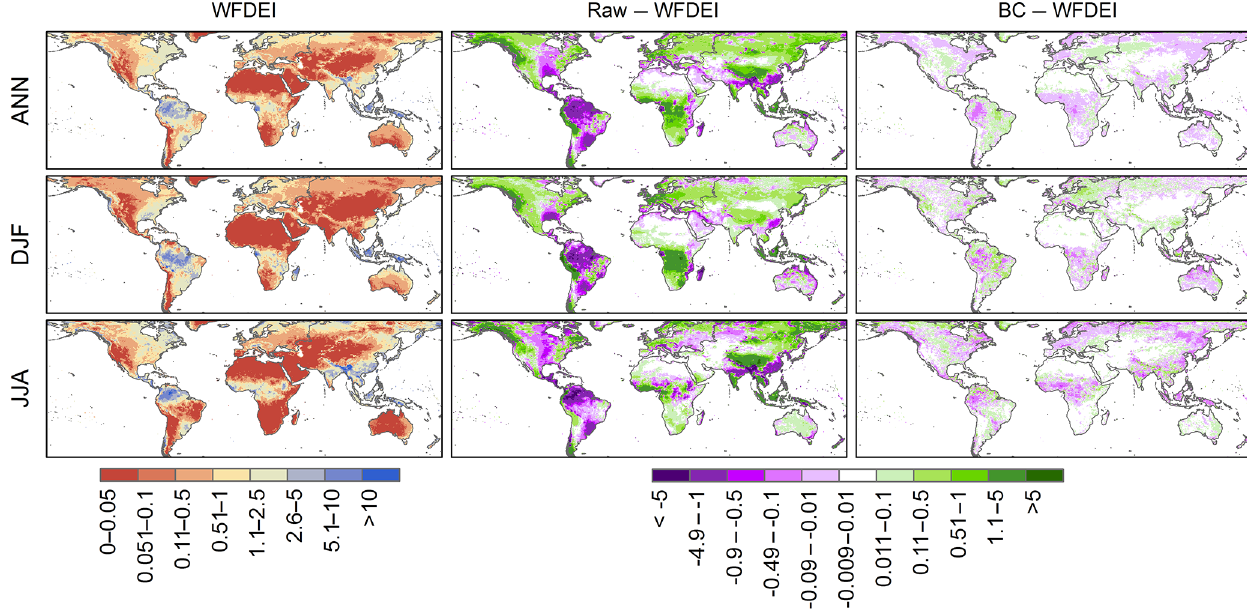
Figure 7. Runoff (mmday − 1 ) from WFDEI data (left column). Initial (raw-WFDEI) and remaining (BC-WFDEI) biases in runoff are shown in the middle and right columns respectively. Results are shown for long-term annual averages (ANN) and for December–January–February (DJF) and June–July–August (JJA) averages of the 1981–2010